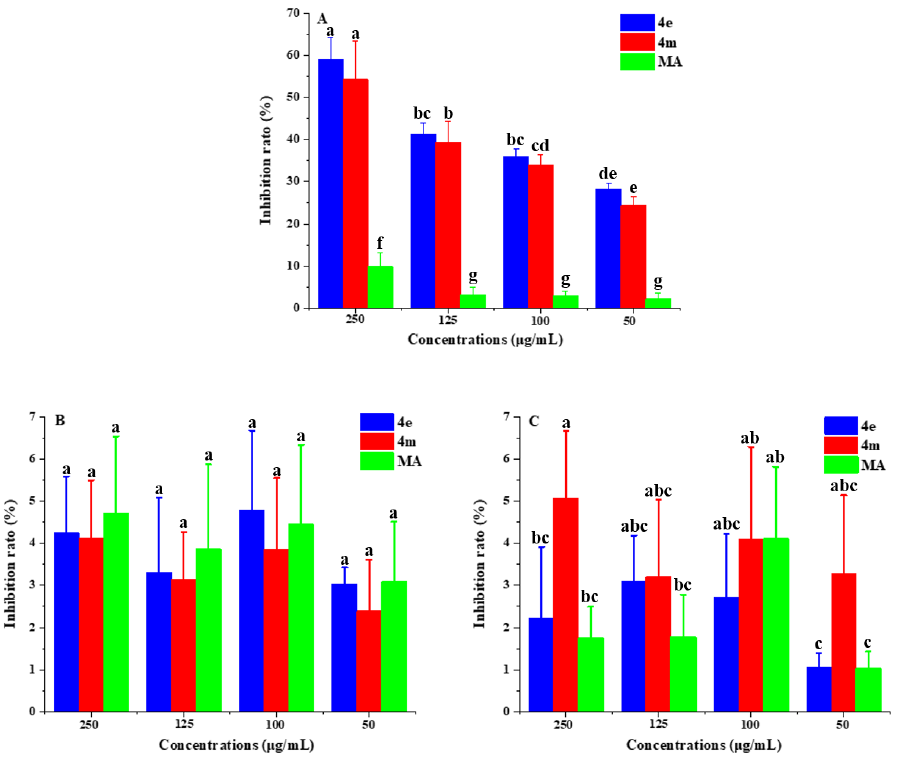
Figure 5. Inhibitory activity of MA , 4e , and 4m against larval ( A ) AchE; ( B ) GST; ( C ) nonspecific esterase. Error bars show 95% confidence intervals (CI). Different letters indicate significant differences at p < 0.05.